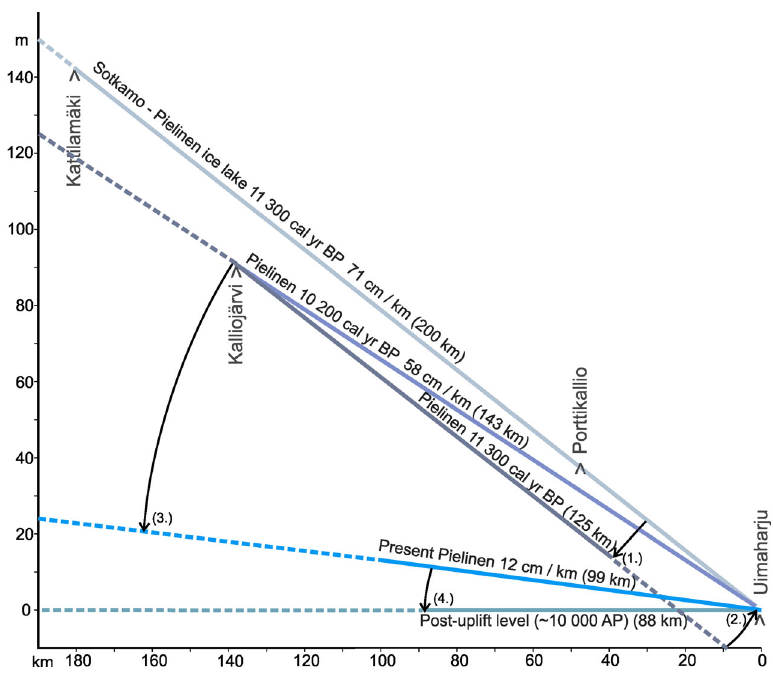
Fig. 4. Tilting of the shorelines corresponding to the main developmental stages of Lake Pielinen. The gradients are given in relation to the post-uplift shoreline, roughly at 10 000 years after present. The numbering indicates the chronological order of the shoreline